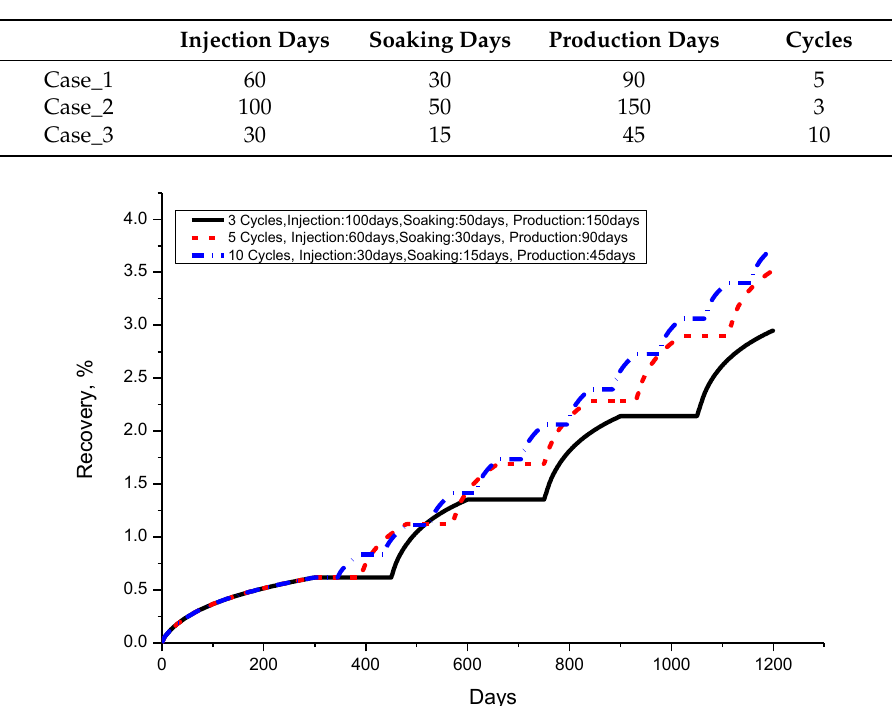
Figure 15. Cumulative oil production of different injection pattern times.